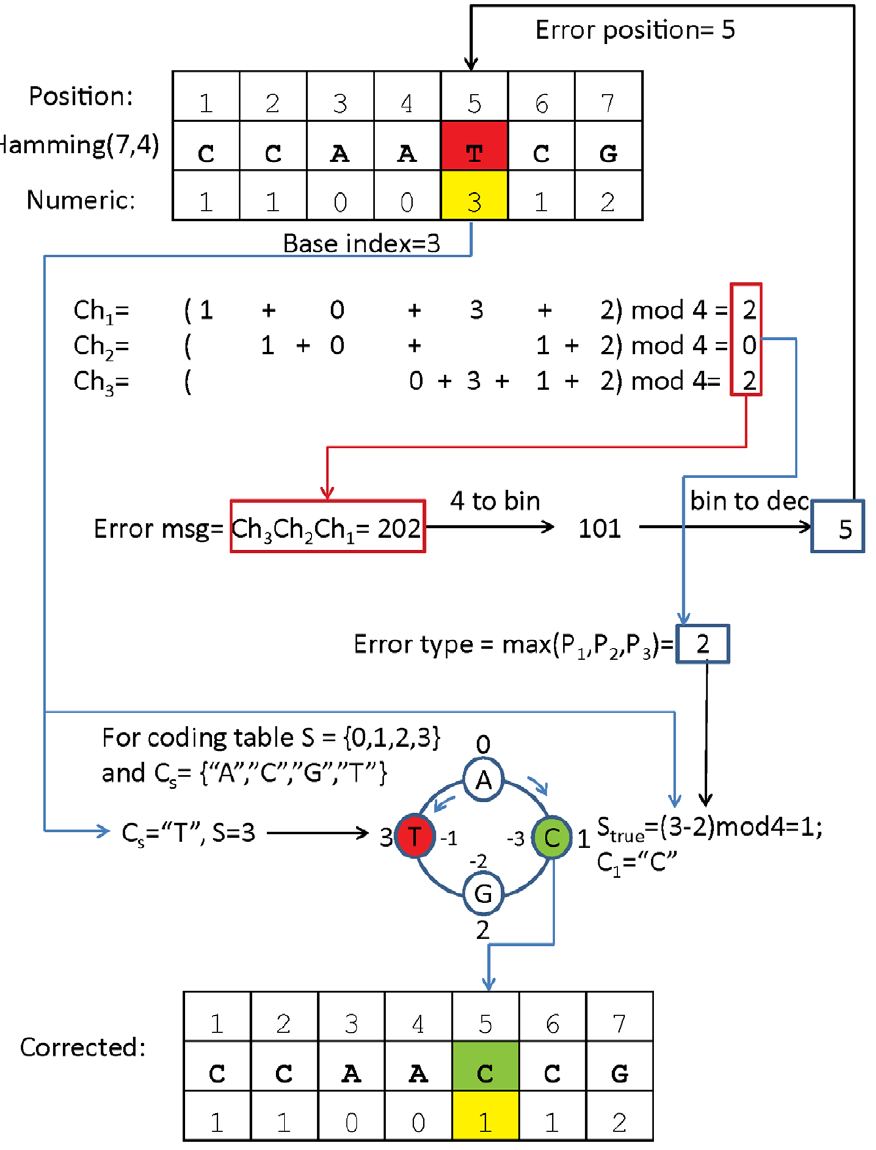
Figure 1. A concept of Hamming error correction in quaternary format. A 7-base sequence is indexed by position and value of each base is provided. With those values checksums are calculated and possible error is detected (in the given example ‘‘T’’ is an error). Max(Ch i ) =2 gives the type of the error, sequence Ch 3 ,Ch 2 ,Ch 1 =202 is transformed to binary 101 (with the rule: if Ch i . 0 then Ch i =1 ), which is equal to decimal 5. This defines position of the error. Since the value at erroneous position is 3 (for C s =’’T’’ S =3), the correct value should be 3 2 2=1. For S =1, C s =’’C’’. Thus, the barcode should be corrected at the position 5, the correct base is ‘‘C’’. Note when calculating correct base: if S true , 0 then use ‘‘the wheel rule’’ ( 2 3 is 1, 2 1 is 3, 2 2 is 2), which can be often (not always!) replaced by mod 4 operation. In short: S true = (erroneous base value - error type) mod 4